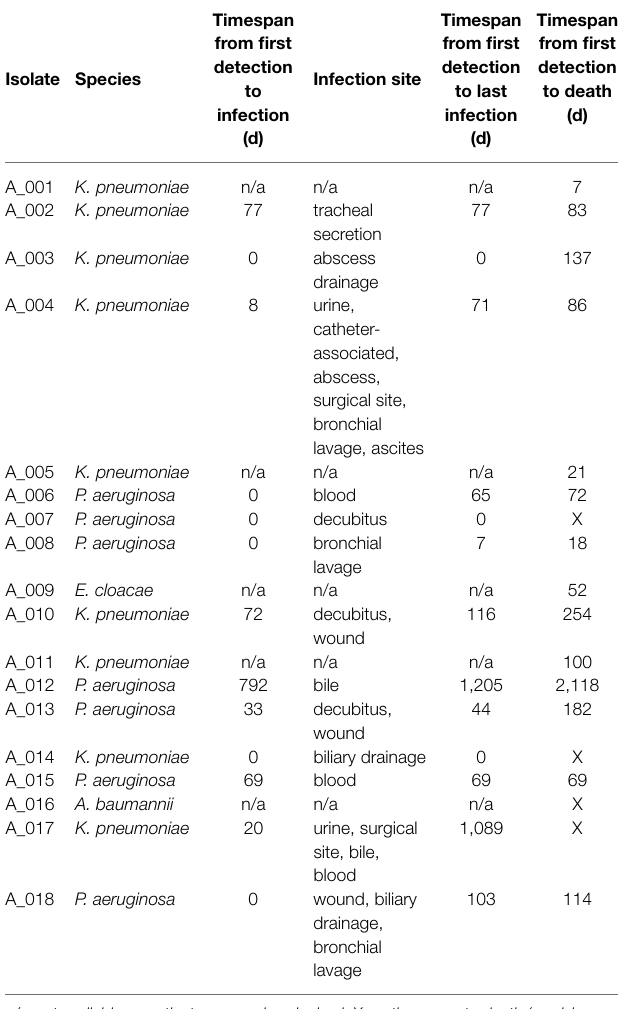
TABLE 1 | CRGN bacteria analyzed in this study. of note, all but three specimens (A_008, A_016, and A_018) were also found in rectal swabs, meaning that 14/17 patients (82%) were intestinally